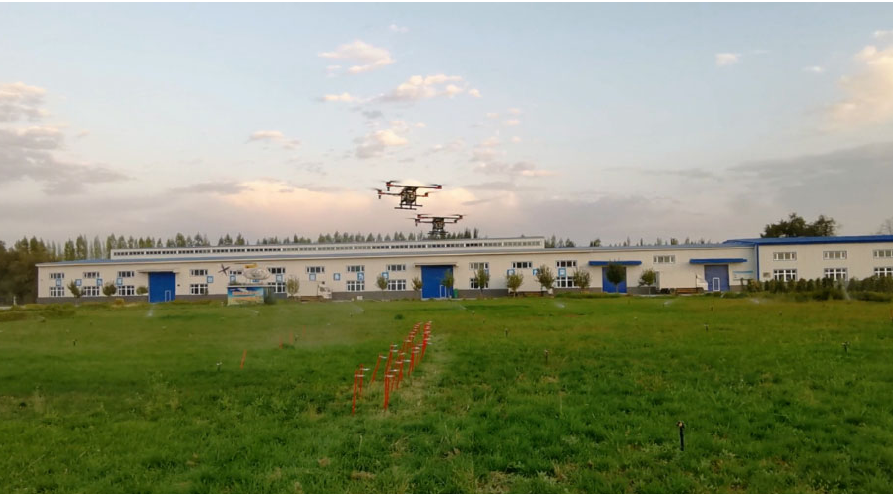
Figure 14. Side view of dual ‐ UAV simultaneous spraying.